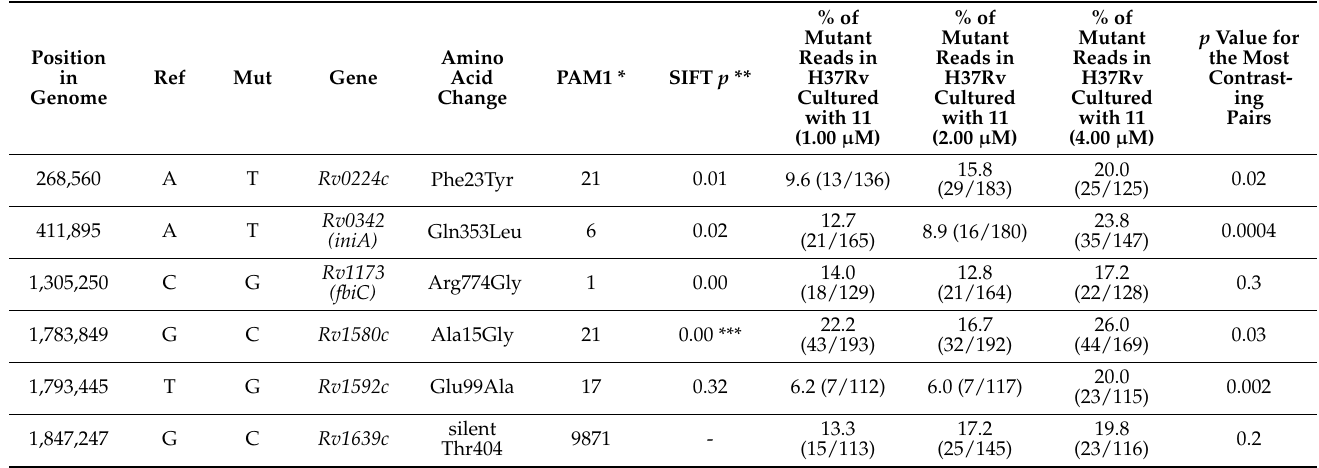
Table 3. Characteristics of the mutant positions in subcultures of M. tuberculosis H37Rv grown under different concentrations of 11